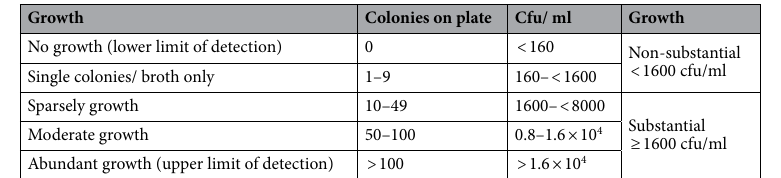
Table 4. Quantification by microbial